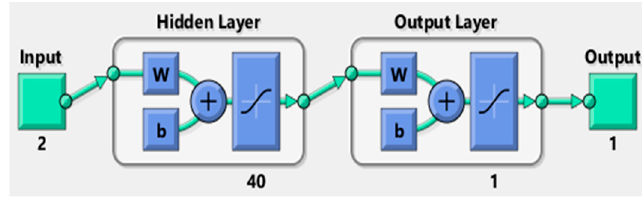
Figure 11. MATLAB model of an ANN structure.